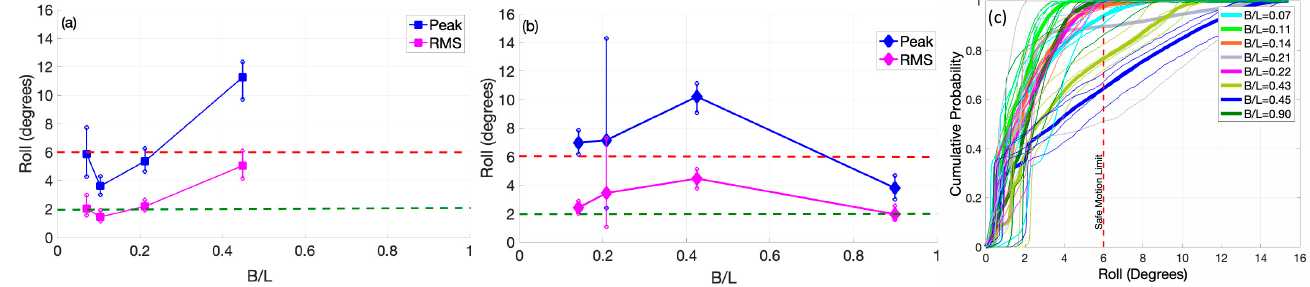
Figure 9. Peak and RMS Roll Plotted Against Beam-to-wavelength for: ( a ) Narrow Pontoon and ( b ) Wide Pontoon. Upper red dashed lines show peak SML and lower green dashed line RMS SML. Range between 5 sensors and 3 test repetitions shown by vertical lines and solid symbol being the average of the 15 results. ( c ) Presents the CDF of the Peak Roll for all sensors and tests.